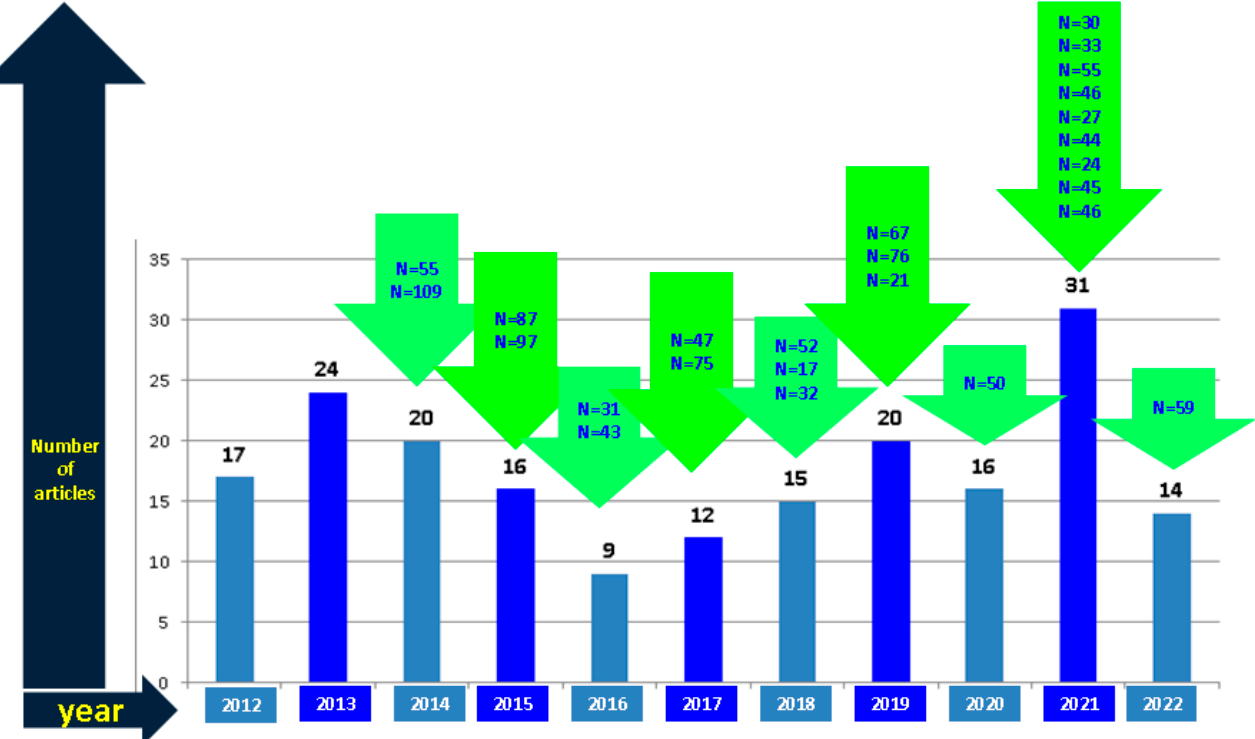
Figure 4. The timeline of original papers specifically addressing PA according to our methodology: the sample size analysis of original publications (please see references according to Table 1).